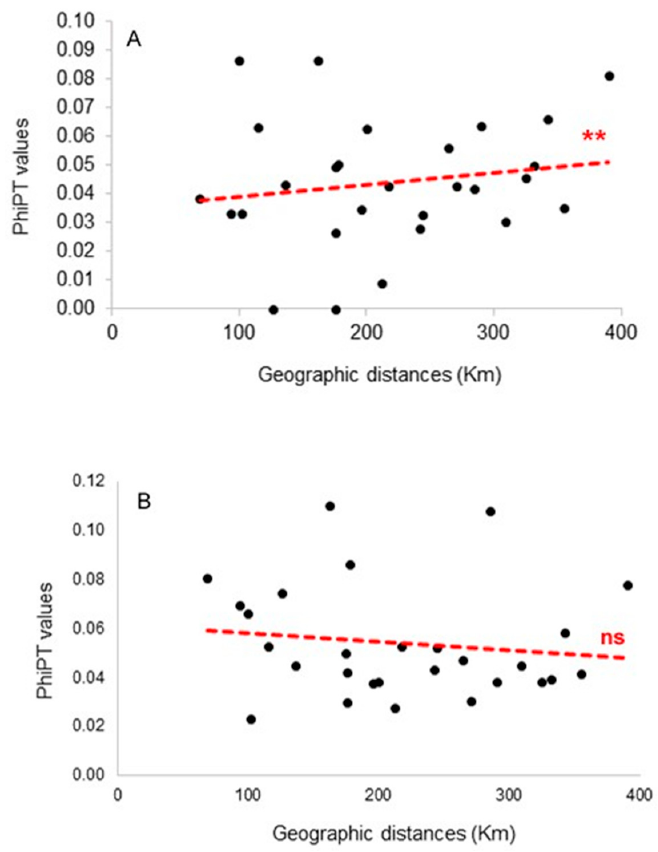
Figure 5. Isolation ‐ by ‐ distance analysis (IBD) for females ( A ) and males ( B ) of Eunica tatila . Results of Mantel test: ** p < 0.01, ns: not significant.